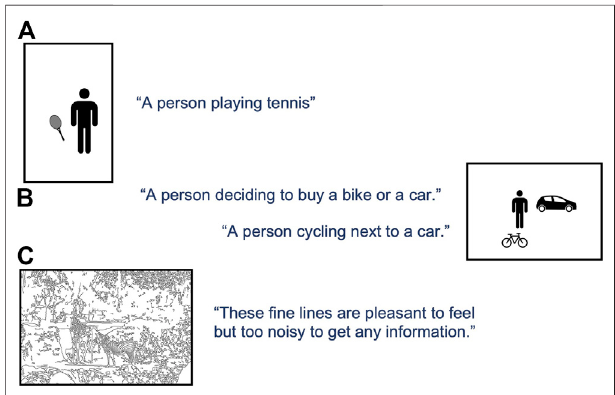
FIGURE 4 | Comments by different participants for some of these